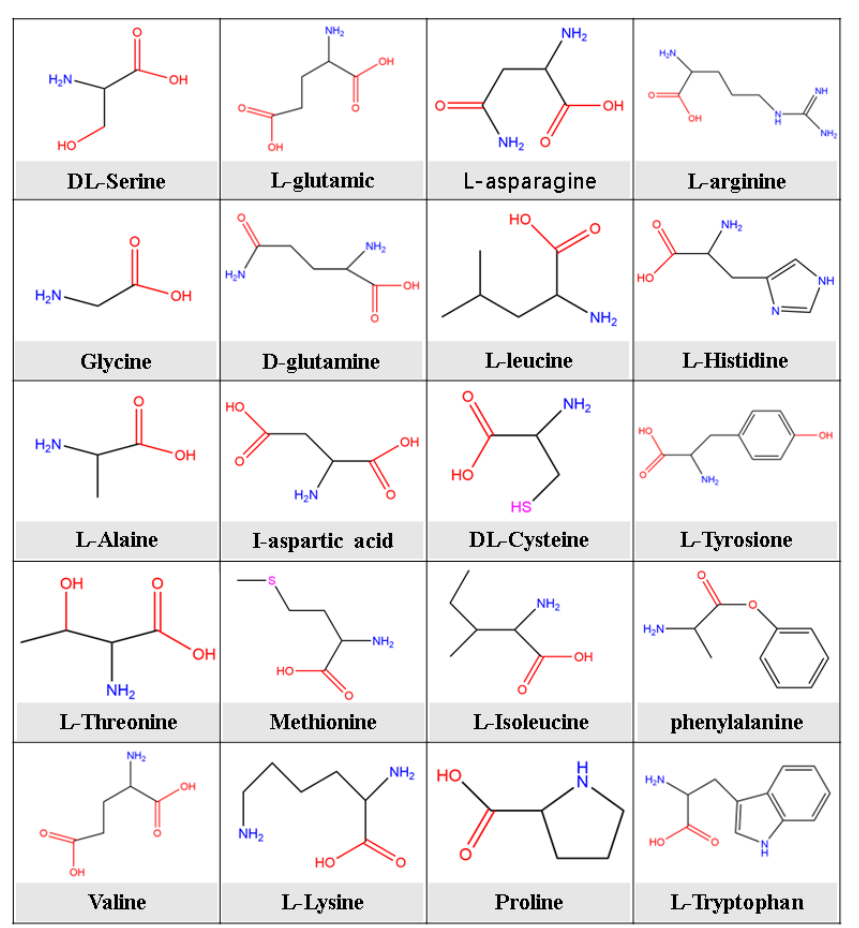
Figure 2. Molecular structure of common amino acids that can be extracted from proteins.